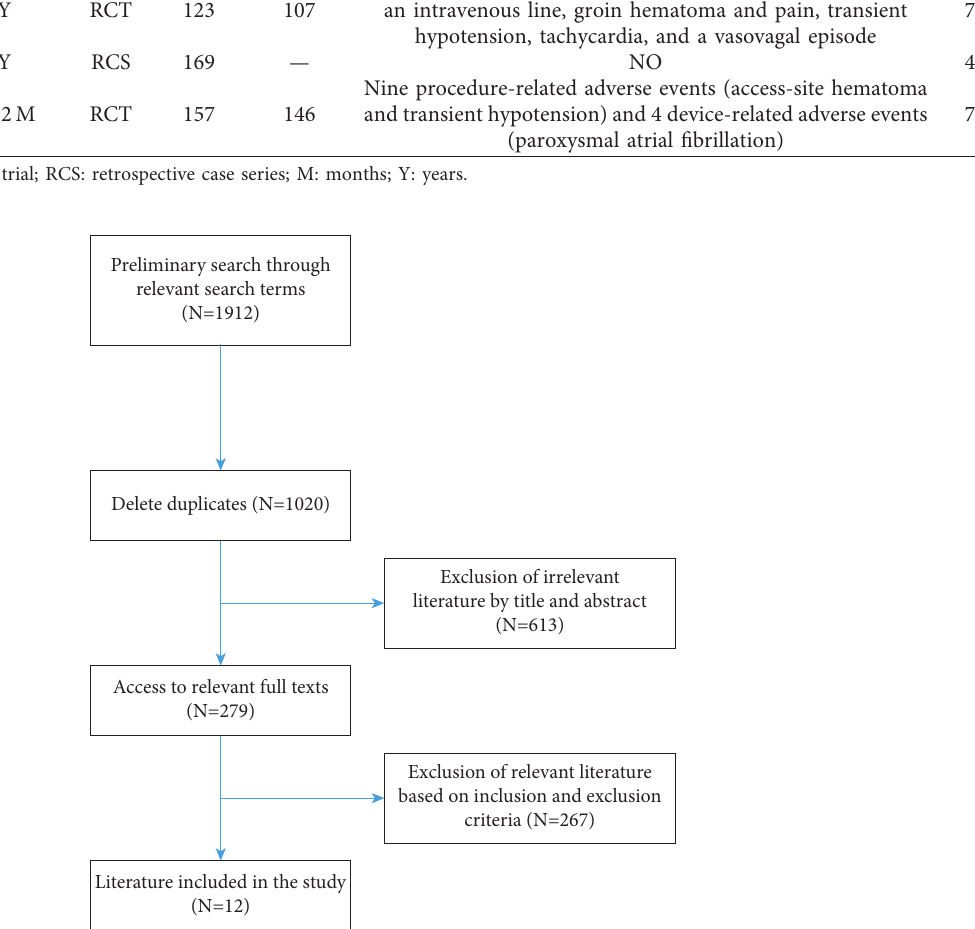
Figure 1: Flow chart of screening